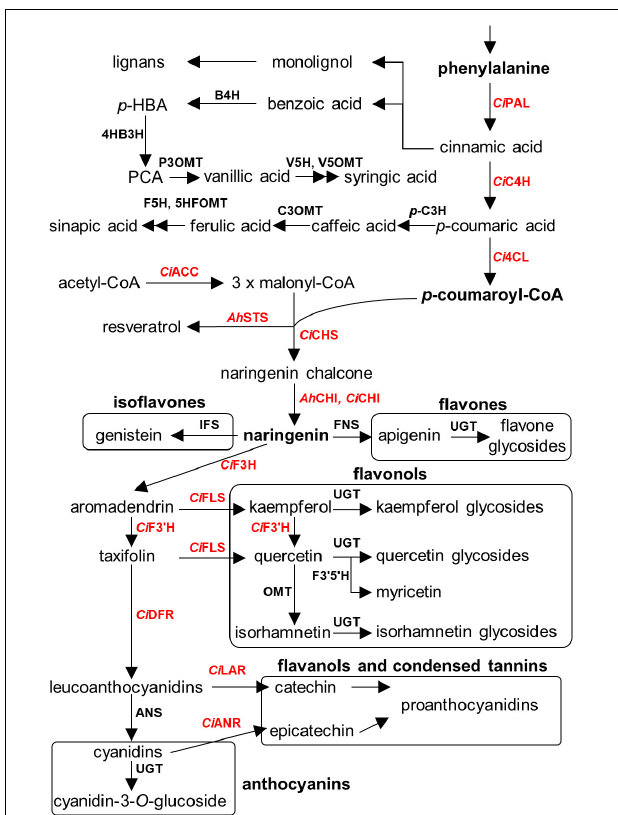
FIGURE 4 | Overview of polyphenolics biosynthesis in major nut plant species. Genes involved in each biosynthetic step are displayed. Characterized genes are shown in red color. Abbreviations used. E4P, erythrose-4-phosphate; PEP, phosphoenolpyruvate; DAHPS,